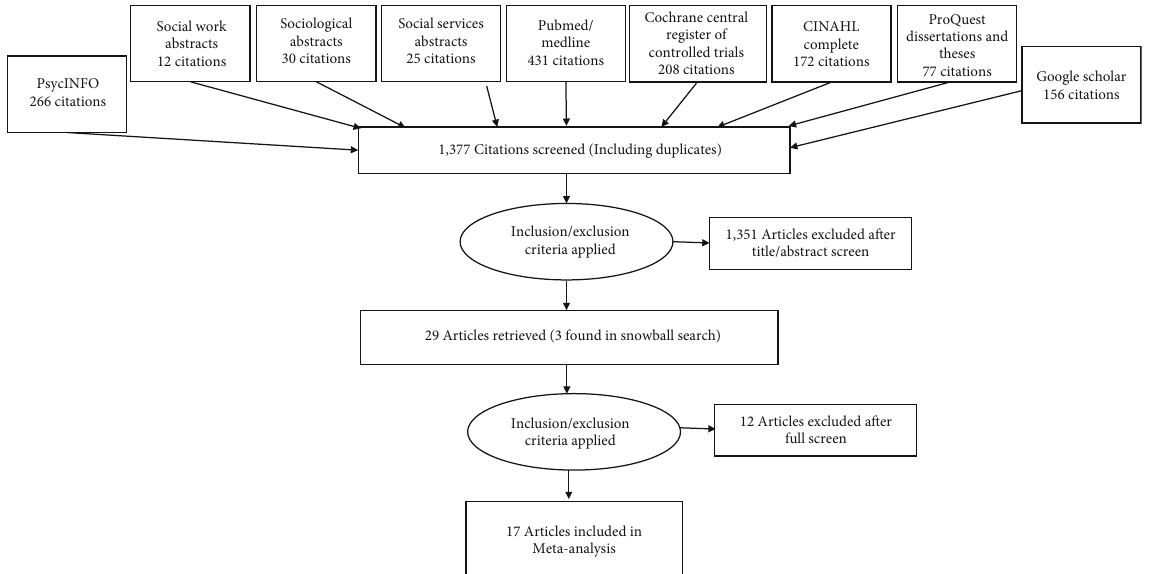
Figure 1: PRISMA diagram of literature search